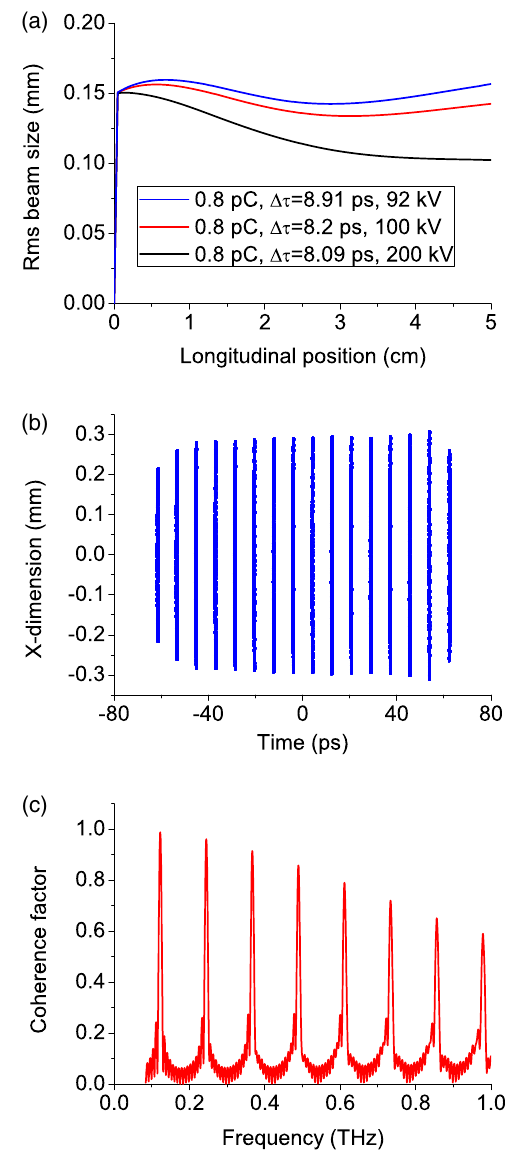
FIG. 3. Electron beam simulation results: (a) the evolutions of rms beam size along the longitudinal position; (b)the cross section distribution state and (c) the coherence factor of the electron beam at the DLW entrance position when the initial time spacing Δ τ ¼ 8 . 2 ps and gun voltage is 100